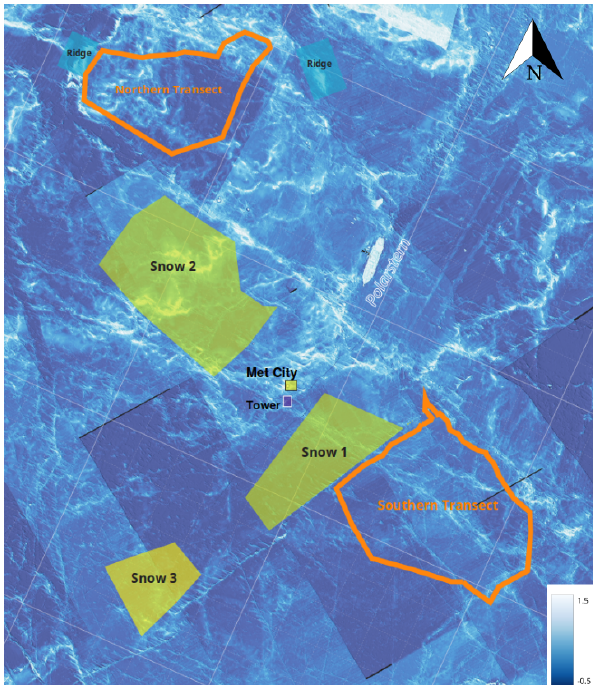
Figure 2. Main snow measuring areas on the MOSAiC floe by 5 March 2020. The bottom layer is a digital elevation map (DEM) from airborne laser scanning (ALS) with the helicopter. The square side length of the underlay grid is 500m. The transect paths and margins of the shaded measuring areas are based on GPS measure- ments. The legend for elevation is shown in metres. However, the elevation range is only approximate due to issues with the inertial navigation system which could not be corrected as of